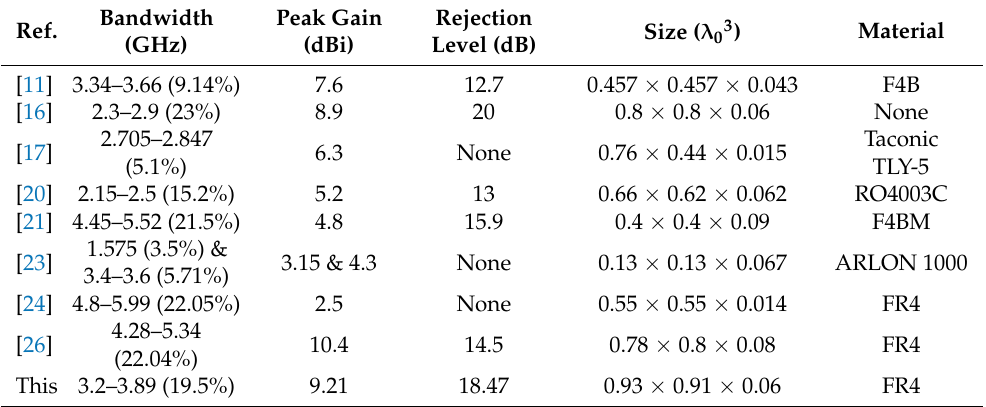
Table 2. Comparisons with other filtering